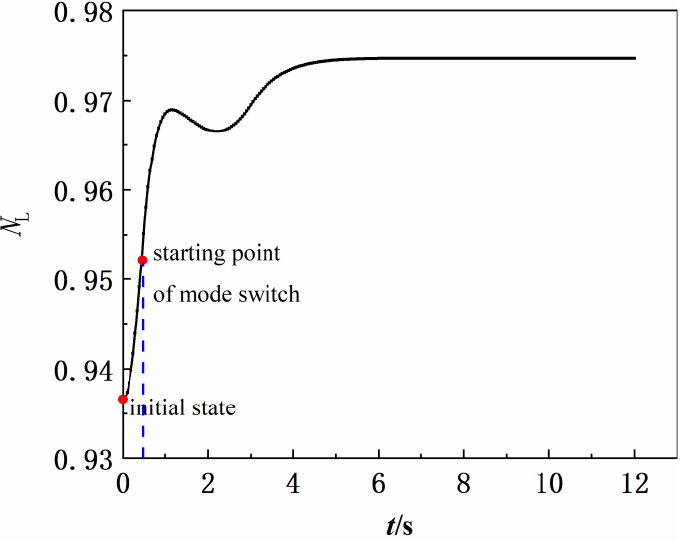
Figure 15. Change curve of low-pressure rotor speed of working-mode switching from single bypass to double bypass at H = 0 km, Ma = 0.